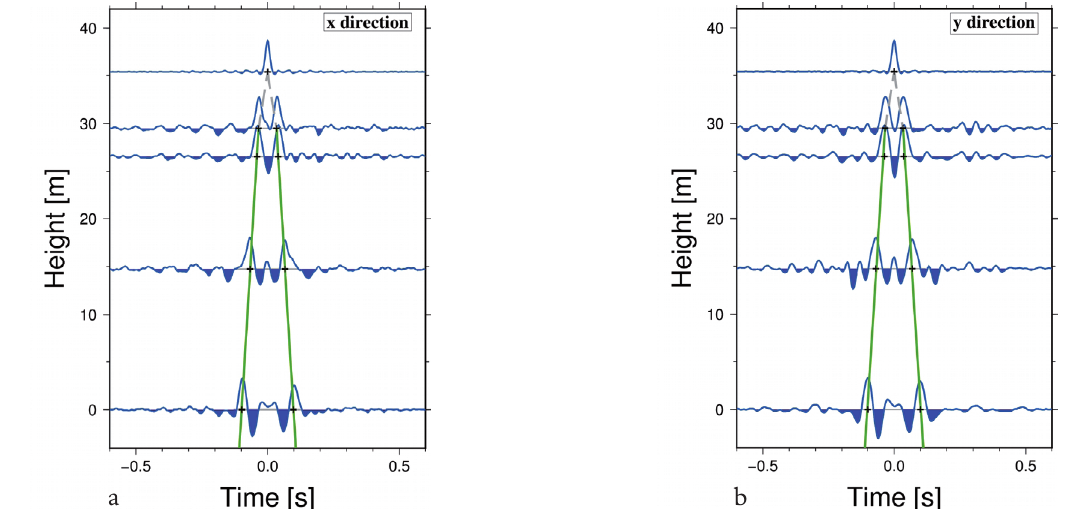
Figure 14. IRFs obtained after deconvolution performed with respect to the 13th floor for position B. (a) x and (b) y -directions. The green and dotted gray lines correspond to the wave propagation velocities estimated using the time-lags between the pulses of up and down-going waves.